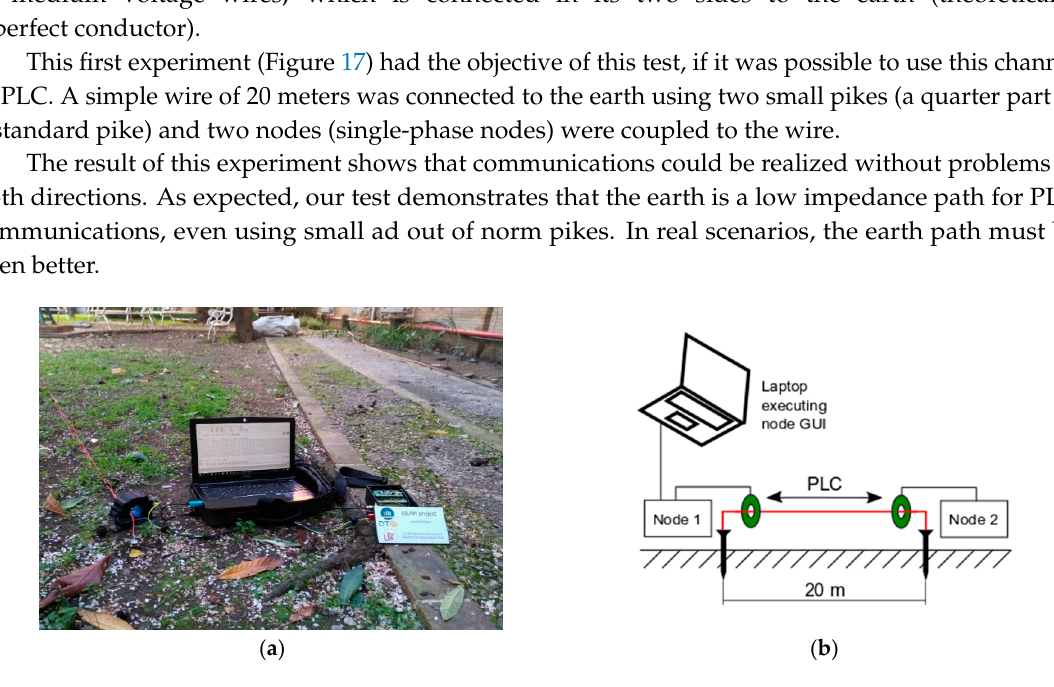
Figure 17. ( a ) Coupled node and laptop; and ( b ) experimental setup.